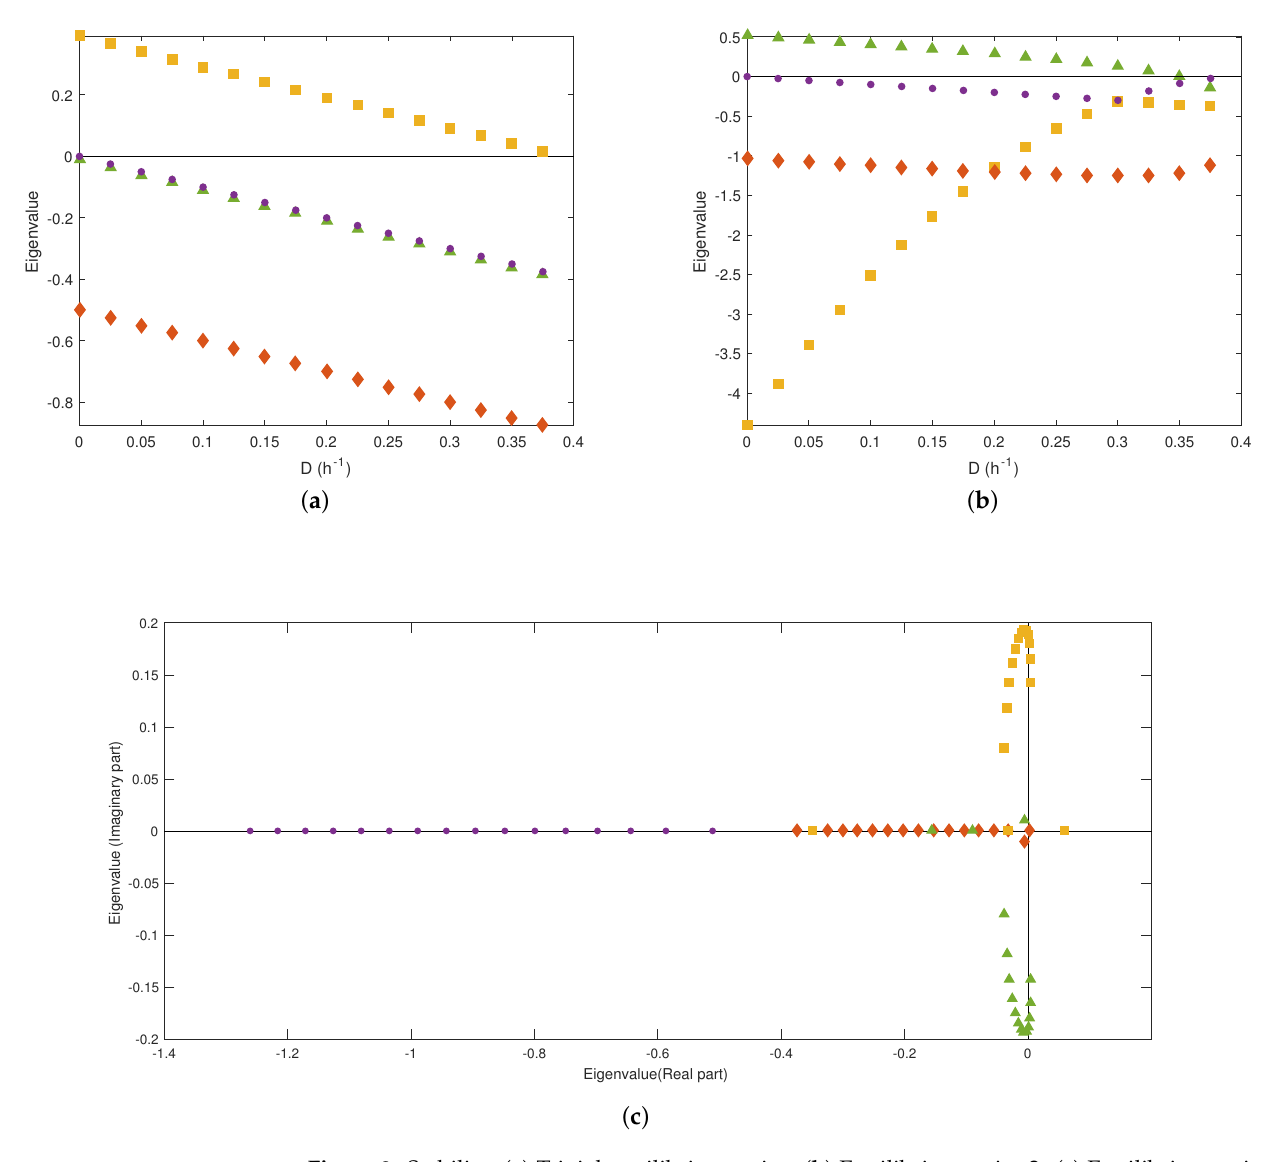
Figure 2. Stability. ( a ) Trivial equilibrium point. ( b ) Equilibrium point 2. ( c ) Equilibrium point 3.